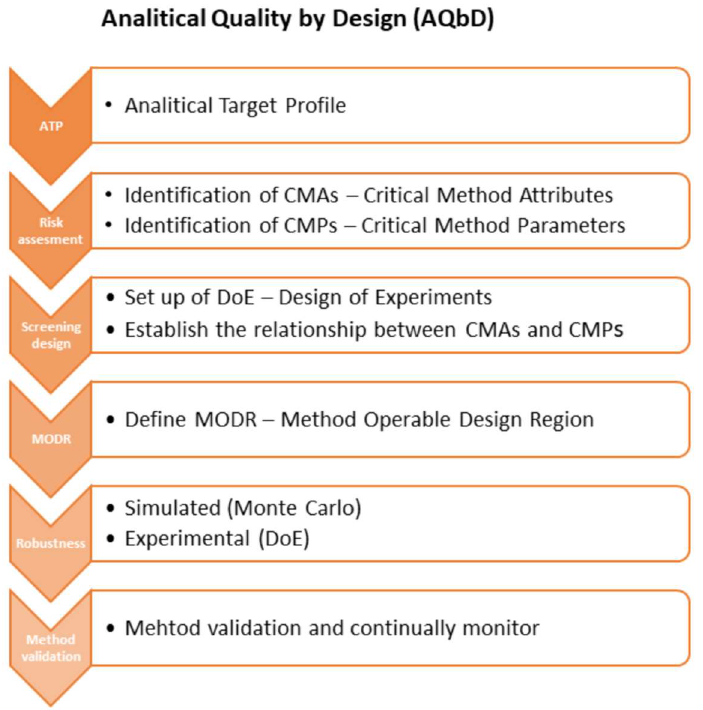
Figure 1. AQbD methodology workflow on the base of Tome at al. [27].